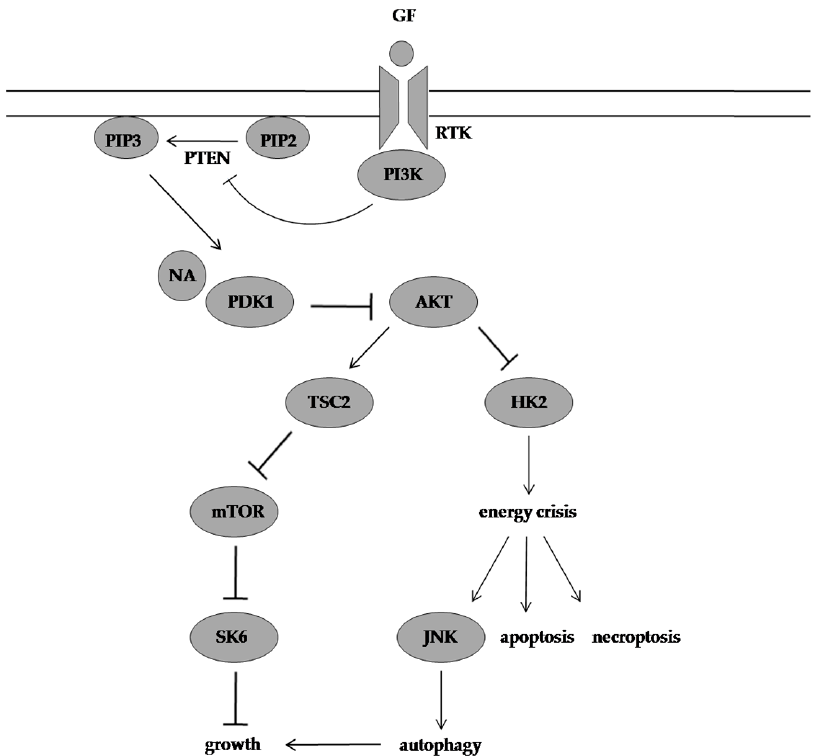
Figure 4. Molecular mechanism of action of NA. NA targets PDK1 and suppresses its downstream effectors resulting in energy crisis, and autophagy provides a survival advantage in NA-treated cells but is unable to prevent cell death in response to this energy depletion. GF:growth factor, RTK: receptor tyrosine kinase, PI3K: phosphoinositide 3-kinase, PIP2: phosphatidylinositol-4,5-biphos- phate, PTEN: phosphatase and tensin homolog, PIP3: phosphatidylinositol-3,4,5-triphosphate,